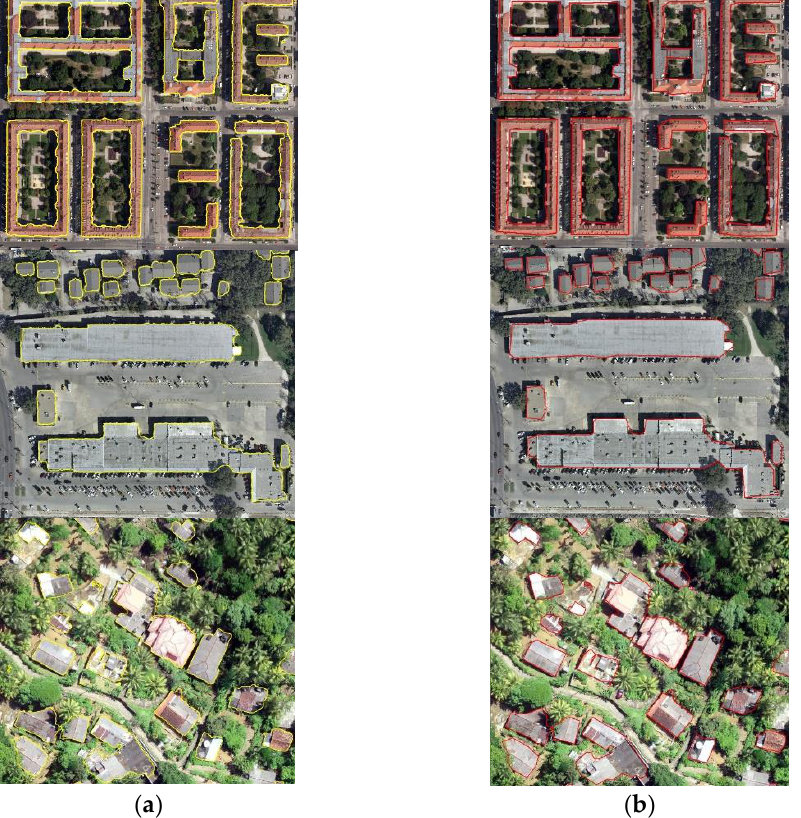
ISPRS Int. J. Geo-Inf. 2021 , 10 , x FOR PEER REVIEW Figure 12. Results comparison of initial and smoothed polygons from DPA with 2% smoothing ratio: ( a ) Initial building polygons; ( b ) Smoothed polygons from DPA with 2% ratio.